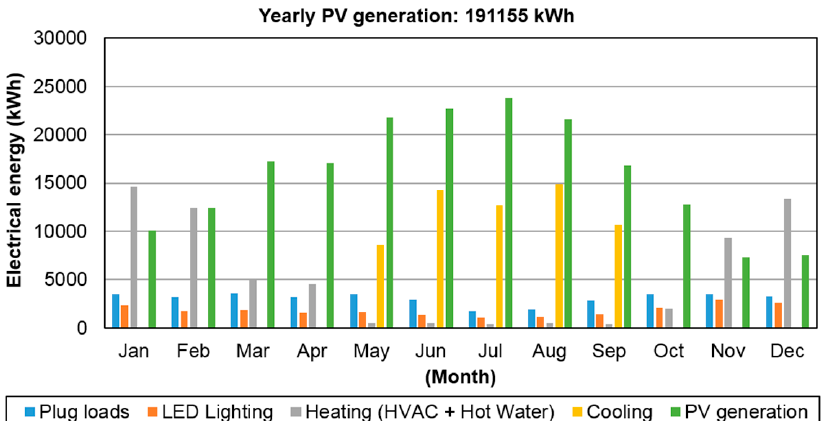
Figure 6. Refurbished building: end-use loads consumption and PV generation.